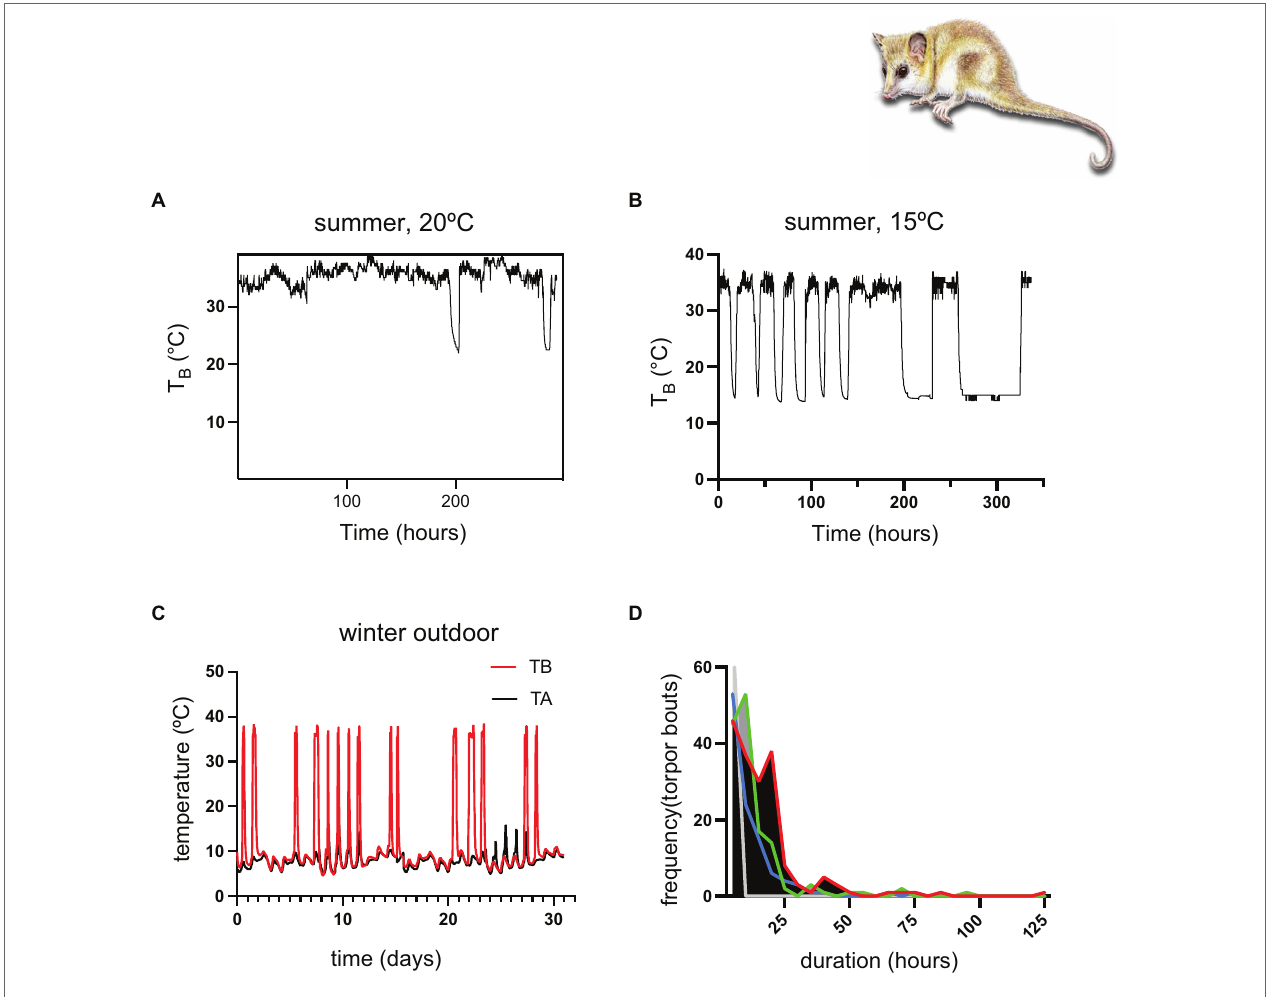
FIGURE 5 | (A) Summer experiments in climatic chambers showing short torpor episodes at T A = 20°C, (B) summer experiment in climatic chambers showing torpor episodes at T A = 15°C, (C) a representative record of one heterothermic individual during winter (August), showing a few multiday torpor episodes of several days and frequent periodic arousals, (D) statistics of the outdoor experiment showing a high frequency of short torpor episodes of 10 h, and some long, multiday torpor episodes of 100–125 h (detailed statistics are shown in Table 1 ; colors represent different